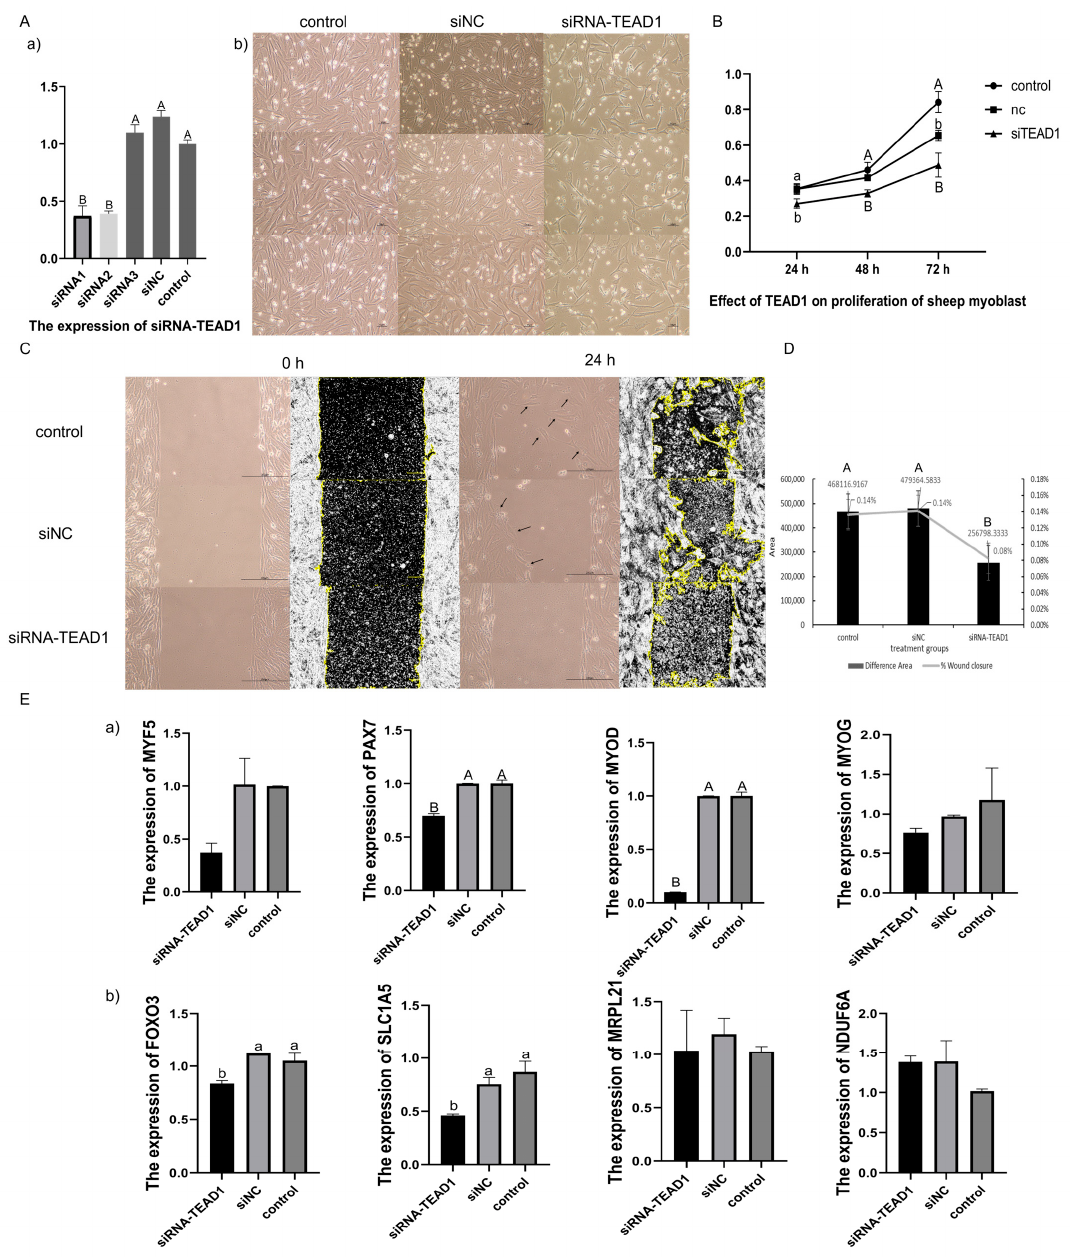
Figure 5. Knocked-down TEAD1 expression inhibited the proliferation of sheep primary embryonic myoblasts. ( A ) Comparing the transfection effect of three siRNAs and the phenotypes of sheep primary embryonic myoblasts transfected with siRNA1-TEAD1, siNC, and control were analyzed. ( Aa ) the expression of TEAD1 gene. ( Ab ) the phenotypes of sheep primary embryonic myoblasts. Scale bar, 50 µ m. ( B ) CCK8 assay of siRNA1–TEAD1 knockdown, where the y-axis is the OD value and the x-axis is time. ( C ) Scratch assay of the siRNA–TEAD1 knockdown. The left picture shows the cell phenotype observed under a microscope, and the yellow highlighted picture on the right shows the use of ImageJ software to analyze the cell damage area. Scale bar, 200 µ m. ( D ) The difference (left y-axis) and ratio (right y-axis) in the cell damage area in the different treatment groups of the scratch assay. ( E ) The qRT-PCR results of related genes after siRNA–TEAD1 knockdown: ( Ea ) muscle growth and development-related marker genes— MYF5 , Pax7 , MyoD , and MyoG ; ( Eb ) TEAD1 -related downstream genes— FoxO3 , SLC1A5 , Mrpl21, and Ndufa6 . a and b represent significant results, and A and B represent extremely significant